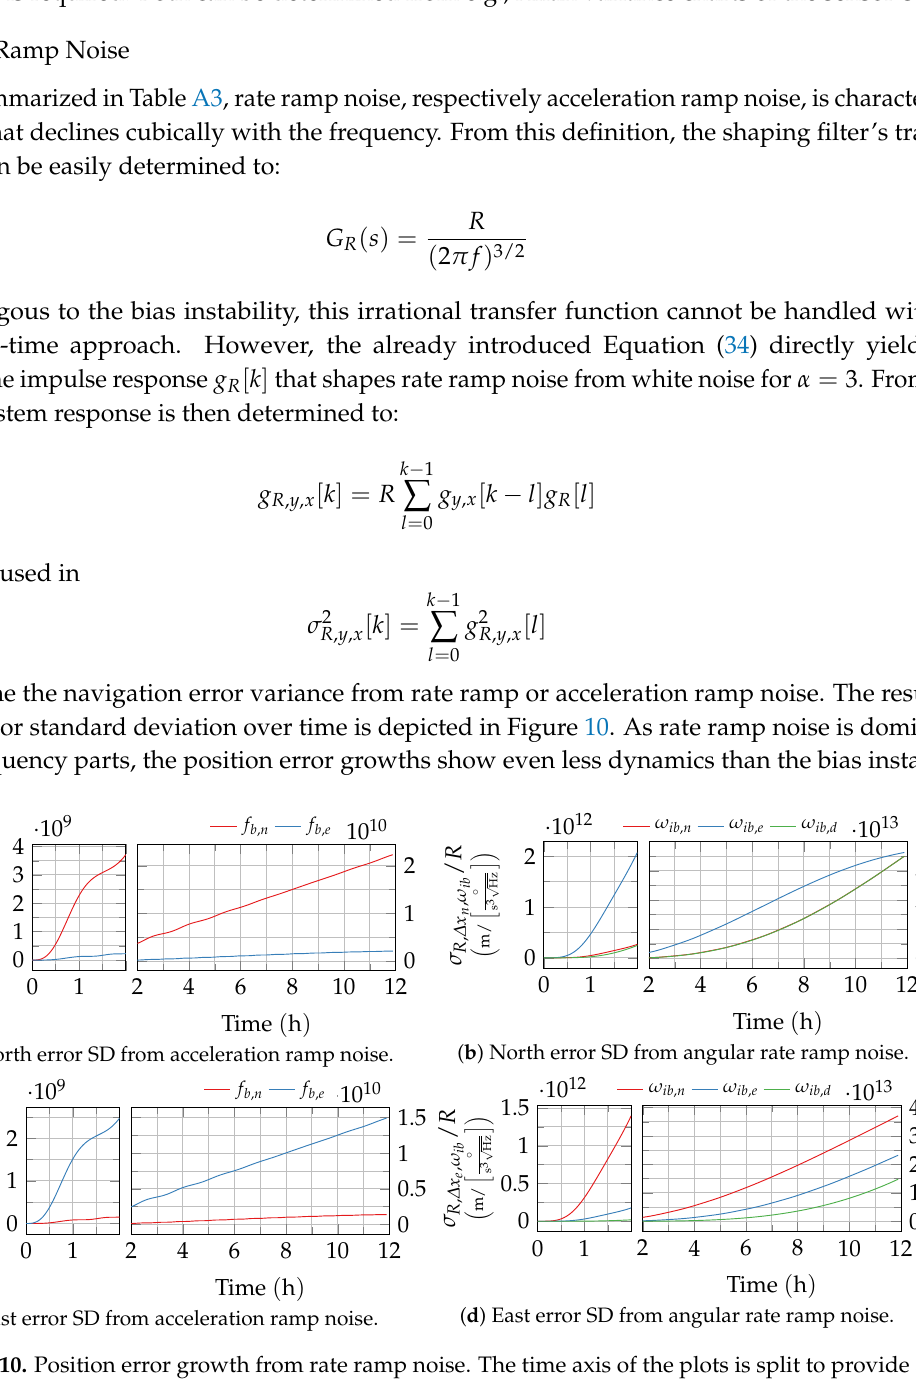
Figure 10. Position error growth from rate ramp noise. The time axis of the plots is split to provide a better resolution of the short-term